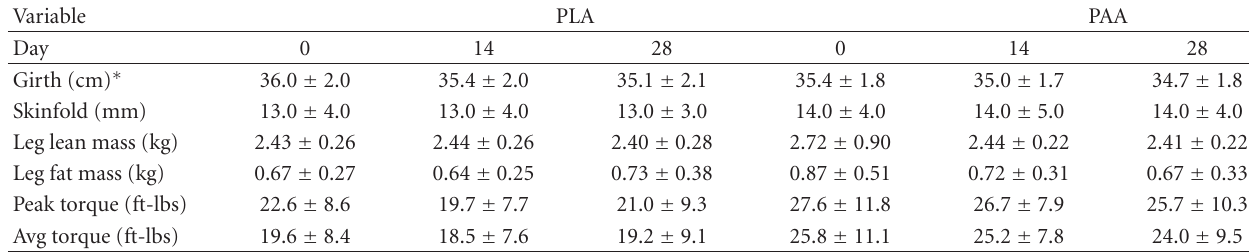
Table 4: Lower leg girth, skinfold, and body composition measurements for placebo (PLA) and protein/amino acid (PAA) groups. All data are presented as mean ± standard deviation. ∗ Denotes a significant time e ff ect.